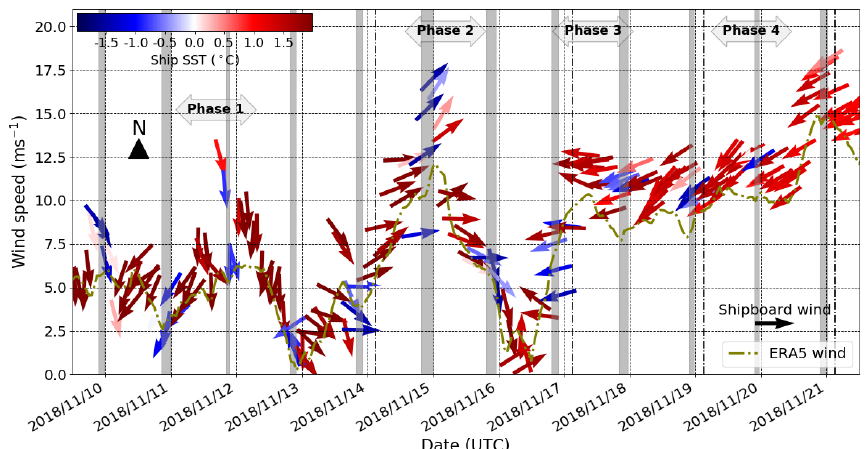
Figure D1. Shipboard wind and SST and bilinearly interpolated ERA5 10m winds at the R/V Mirai position. Grey highlighted times indicate when the vessel was in ice cover based on the ice navigator’s